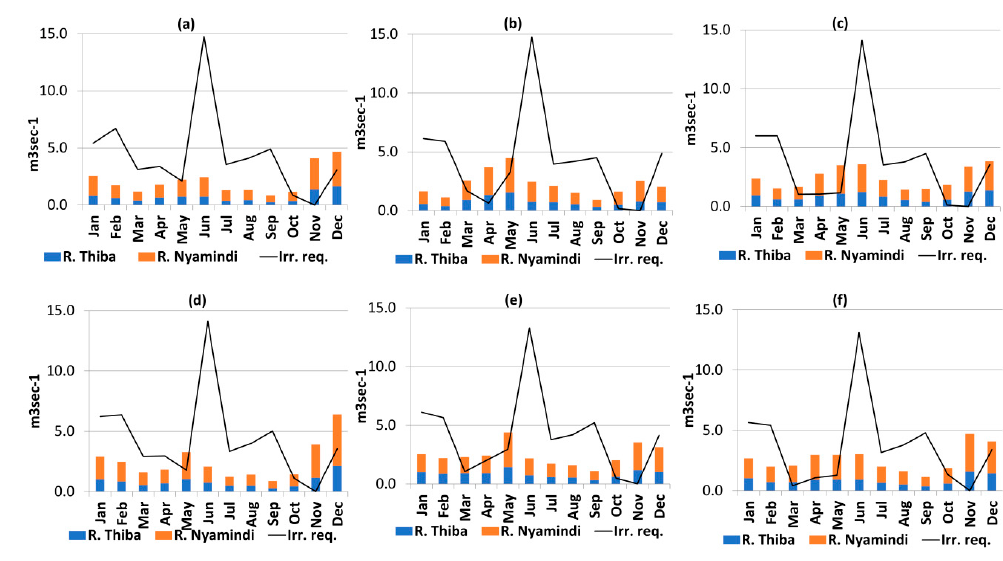
Figure 9. RCP 4.5 Comparison of total available flow and irrigation water requirements during